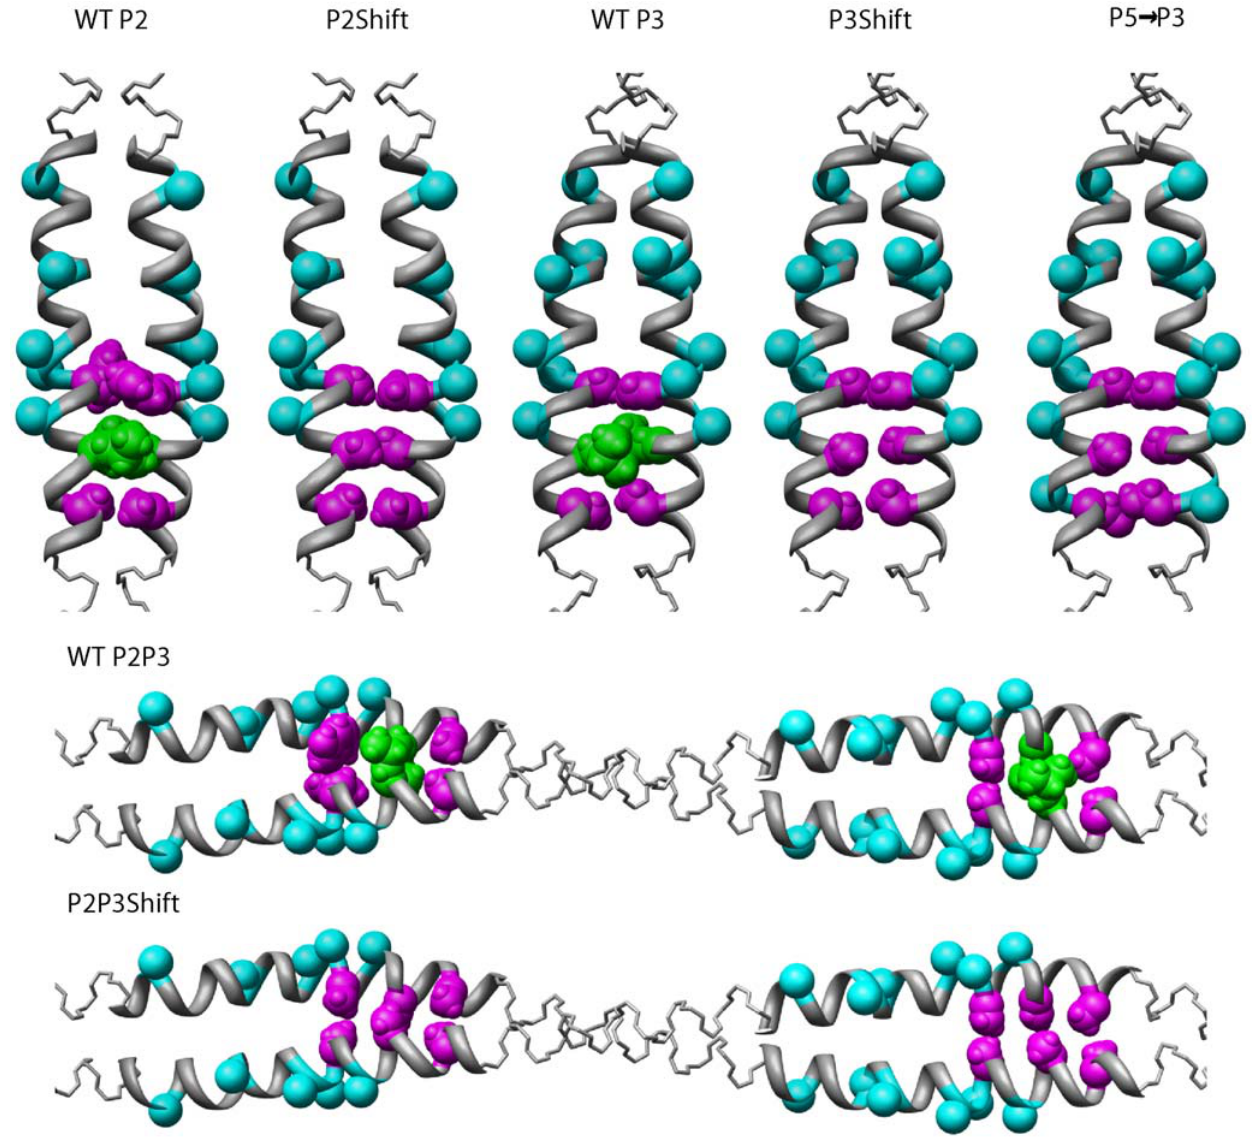
Figure 1. Models illustrating the P2 and P3 regions in wildtype and mutant tropomyosins. The side chains of the alanine clusters (magenta) and consensus actin binding sites (cyan) [13] are illustrated on a ribbon model of the 7 A˚ structure (pdb ID: 1C1G; [60]). Period 2, residues 46–69, and period 3, residues 88–111, are enlarged with the side chains of interface Ala residues (in magenta, space filling), canonical interface residues (green) and consensus residues (cyan, C b in spacefill). The colors used are the same as in Table 1. (Figure 5C, dotted line). There was an excimer peak in the presence of the P3Shift mutations (Figure 5D, dotted line), presumably reflecting the stabilizing effect of the A120L mutation. The shift mutations locally destabilize the coiled coil interface, as indicated by the higher or narrower excimer peak compared to the controls (Figure 5B,D). The distinct behavior of the probe in the three locations illustrates sensitivity to local conformational states of tropomyosin. In each case the temperature of the excimer peak was below the major unfolding transition or overall T M of tropomyosin, indicating local unfolding.